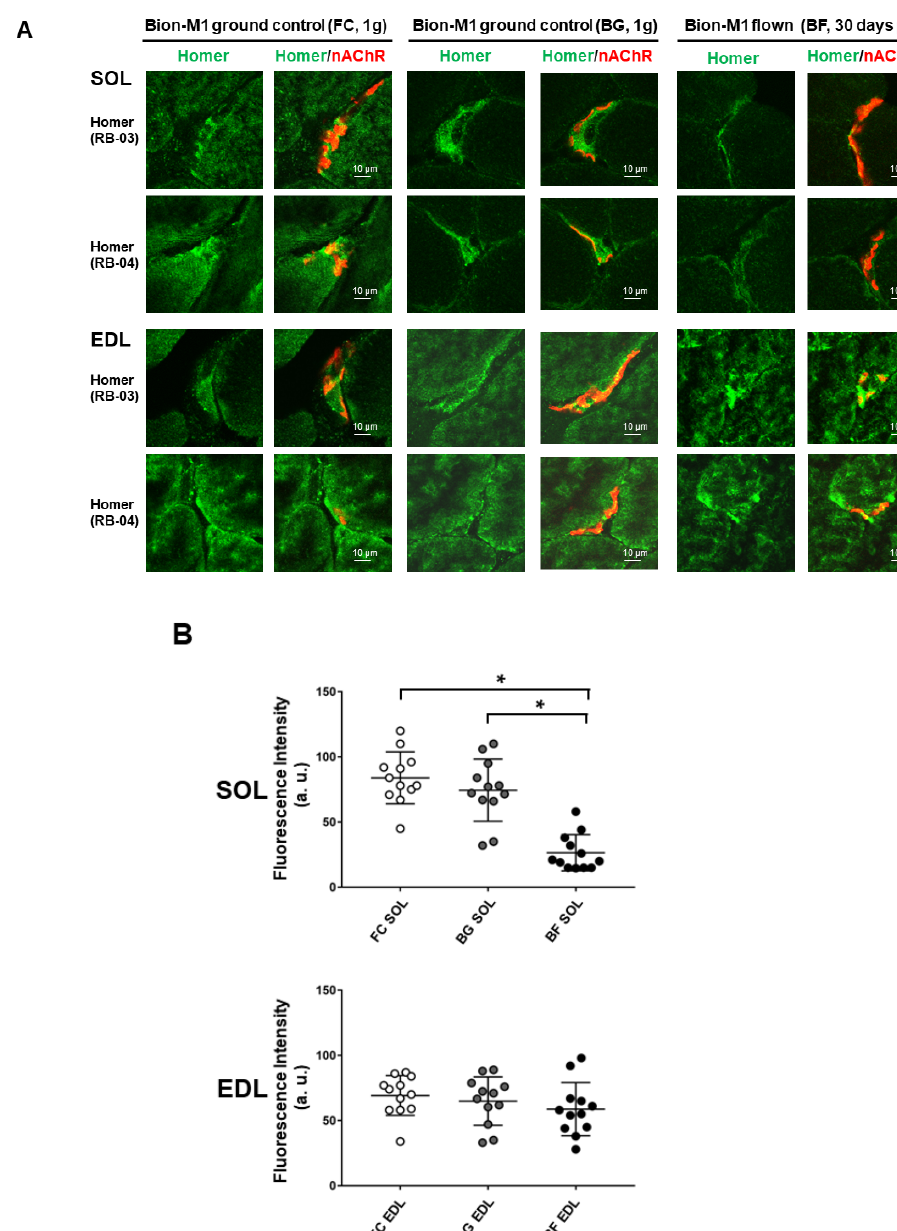
Figure 2. Confocal analysis of Homer immunostaining at the NMJ of SOL and EDL muscles in Bion-M1 flown mice (BF) vs. ground controls (FC and BG). ( A ) A reduction in Homer immunofluorescence signal adjacent to α -BTX stained nAChRs (NMJ postsynaptic microdomain) was observed in Bion-M1 flown mice compared to the Bion-M1 ground controls in SOL but not in EDL muscle. ( B ) Quantification of Homer immunofluorescence intensity at the NMJ of SOL (upper panel) and EDL (lower panel) muscles in Bion-M1 flown mice vs. ground controls. A significant decrease in Homer fluorescence intensity was detected in SOL of BF ( p < 0.001) but not in EDL muscle compared to ground controls BG and FC. Data are expressed as means ± SE. For each experimental group n = 2 male C57BL/N6 mice (19–20 weeks old). Statistical differences between groups were determined by an unpaired t -test. *= indicates significant difference vs. CON (ANOVA p < 0.001). By contrast, no decrease in Homer immunofluorescence intensity was observed in